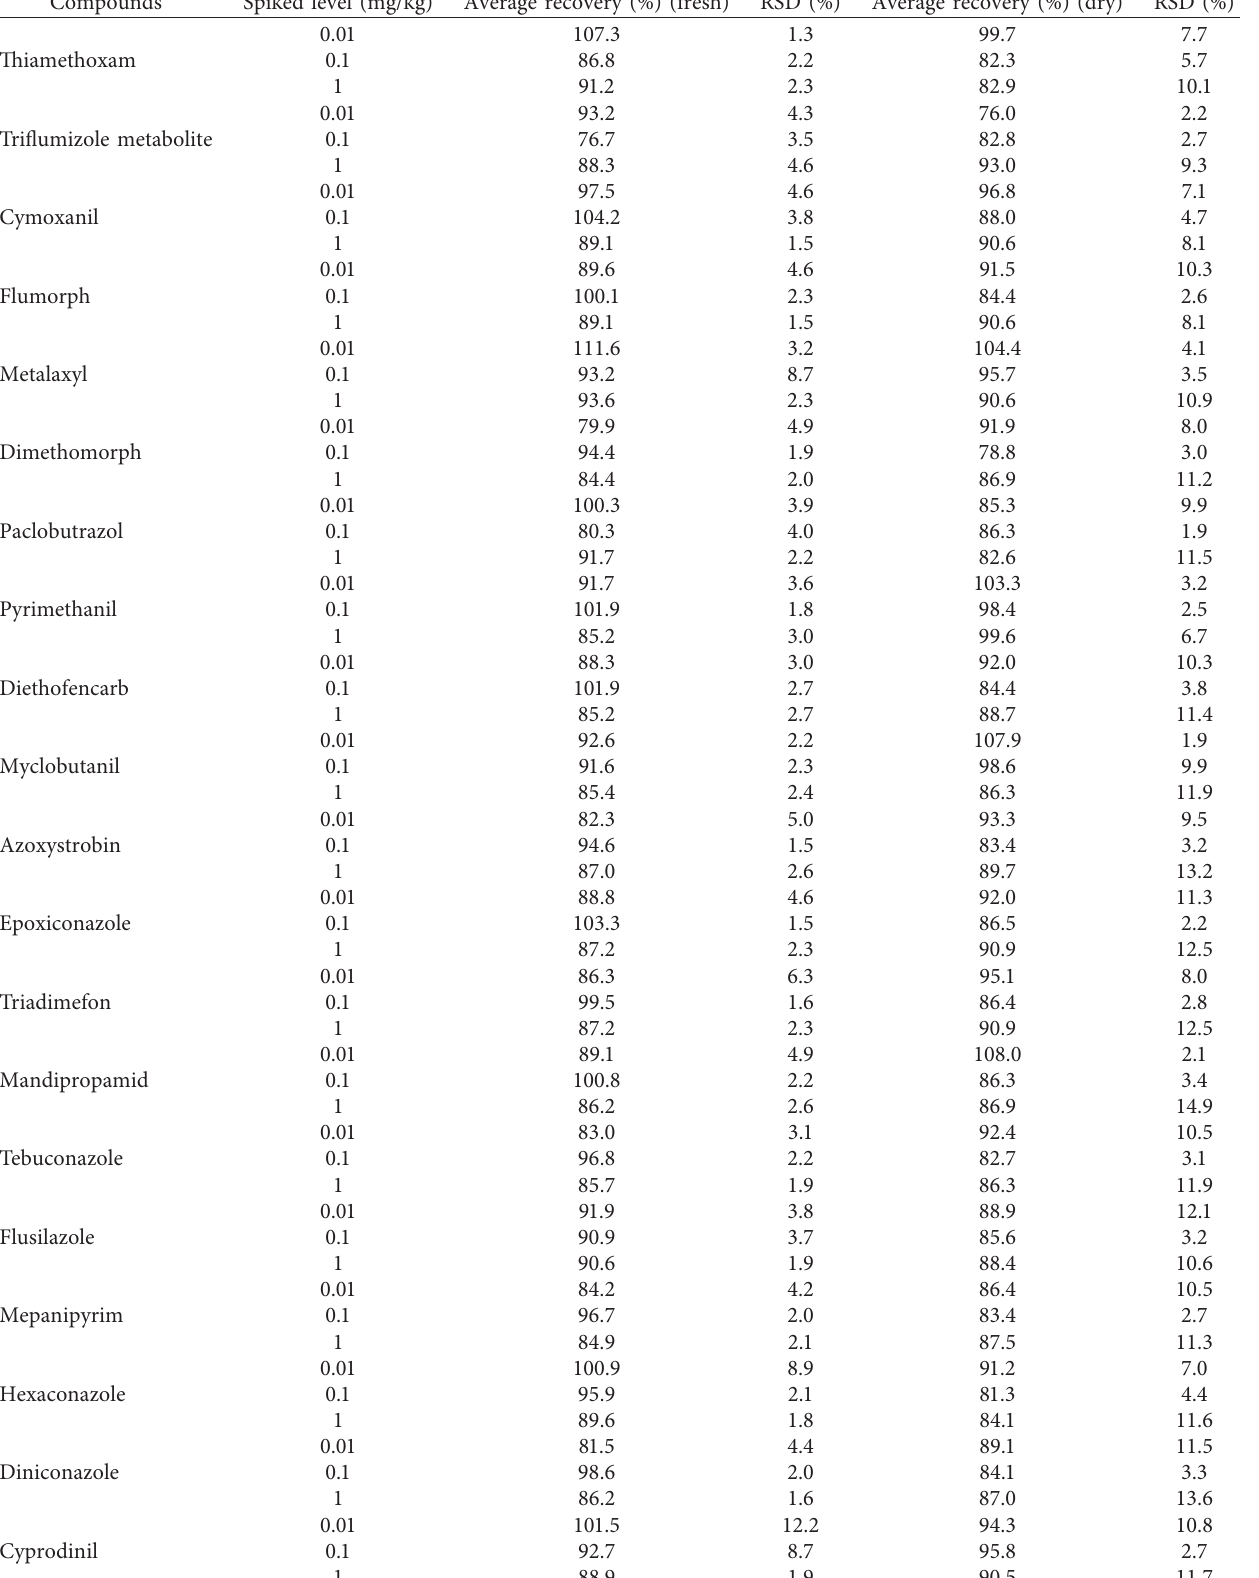
Table 3: Recoveries and precision of detection of 31 pesticides in different ginseng samples ( n � 5).